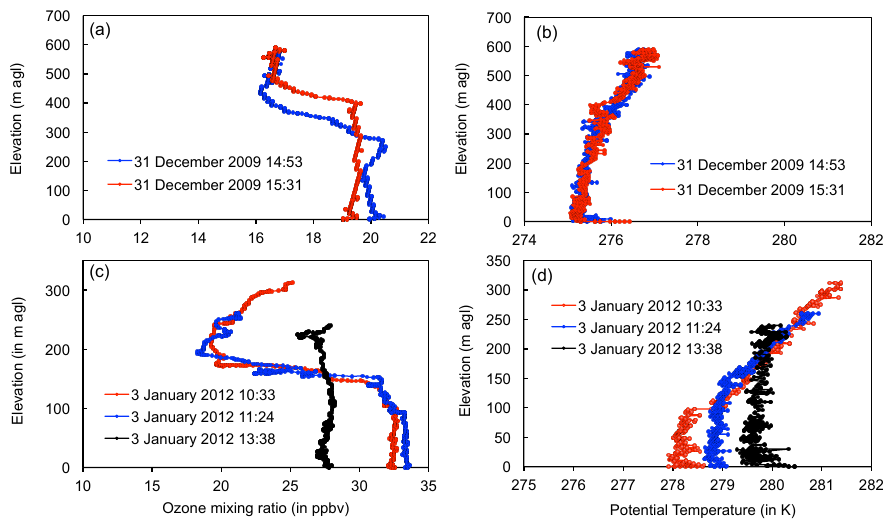
Figure 10. Examples of diurnal vertical ozone distribution changes at Concordia (during the afternoon in a , and from the morning to the afternoon in c ), along with corresponding potential temperature profiles ( b, d , respectively). Dates are reported in local time and elevation in